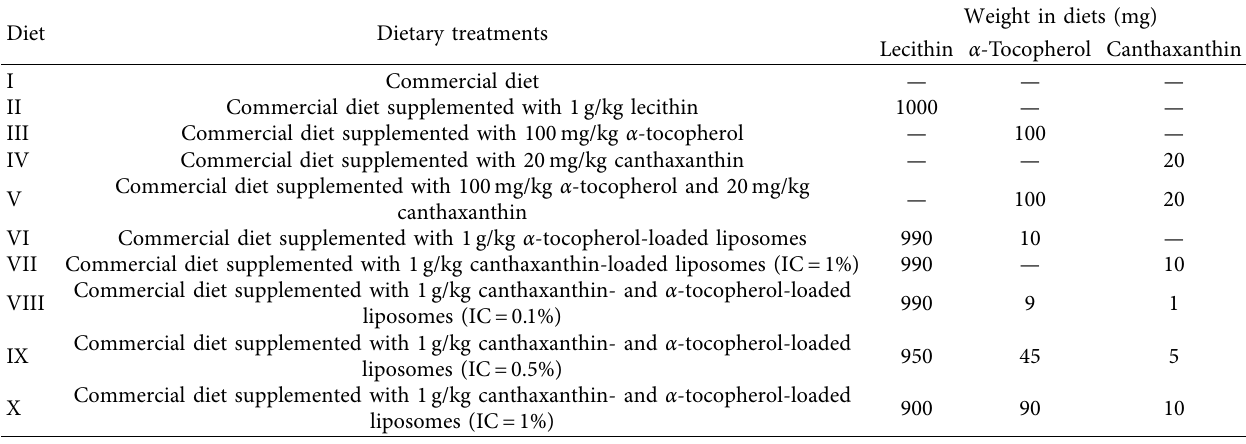
Table 1: Composition of artificially composed fish feeds used in the feeding